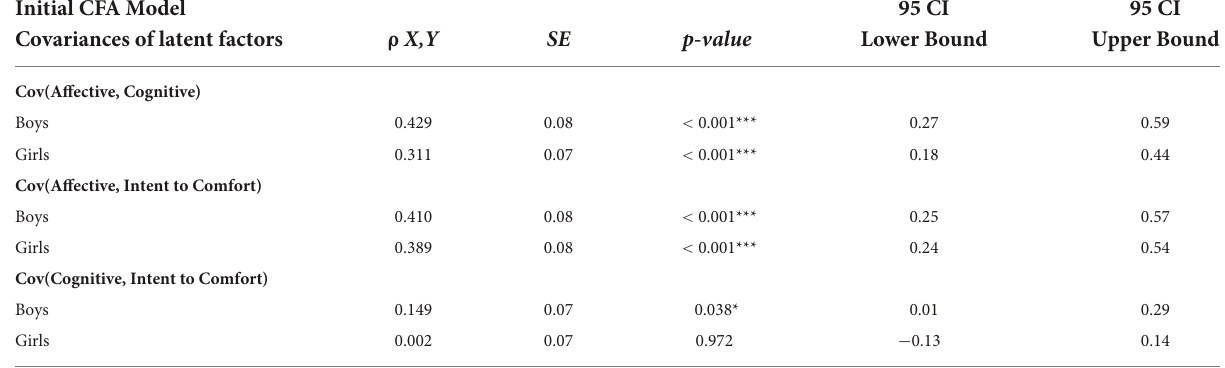
TABLE 4 Covariance between affective, cognitive, and intent to comfort latent factors by gender. Initial CFA